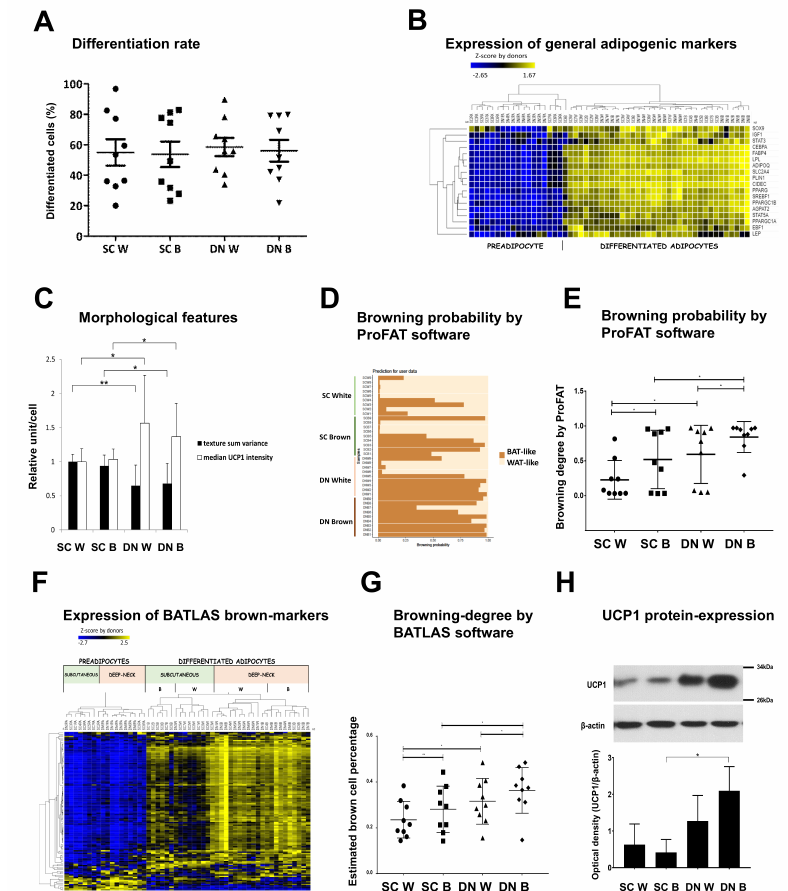
Figure 2. The degree of di ff erentiation and browning of subcutaneous (SC) and deep-neck (DN) adipocytes. ( A ) Ratio of di ff erentiated adipocytes over the total number of cells. ( B ) Heat map displaying the expression profiles of general adipocyte marker genes. ( C ) Texture sum variance and median Ucp1 protein content of adipocytes (as compared to SC white adipocytes) per cell. In every experiment, 2000 cells per each sample were recorded and measured. ( D ) Based on the raw gene-expression data the browning probability of the samples was analyzed and visualized by ProFAT software. ( E ) Browning probability considering tissue origin and di ff erentiation protocol. ( F ) Expression profile of BATLAS marker genes in SC and DN adipose progenitors and di ff erentiated samples. ( G ) Estimation of brown cell percentage by BATLAS considering tissue origin and di ff erentiation protocol, n = 9 donor, four samples / donor. ( H ) Expression of UCP1 in adipocyte lysates of one representative donor detected by immunoblotting. Densitometry of immunoblots was performed with samples of three independent donors. W: white di ff erentiation protocol; B: brown di ff erentiation protocol. 1 to 9 labels the